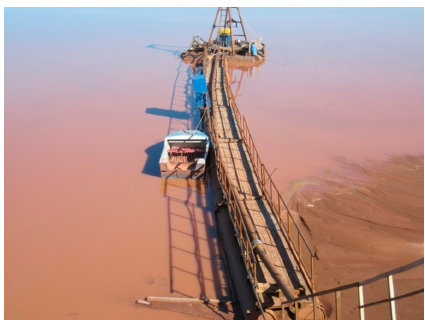
Figure 1. Tailing pond of processing plant, Lomonosov GOK, Severalmaz JSC. Reproduced with